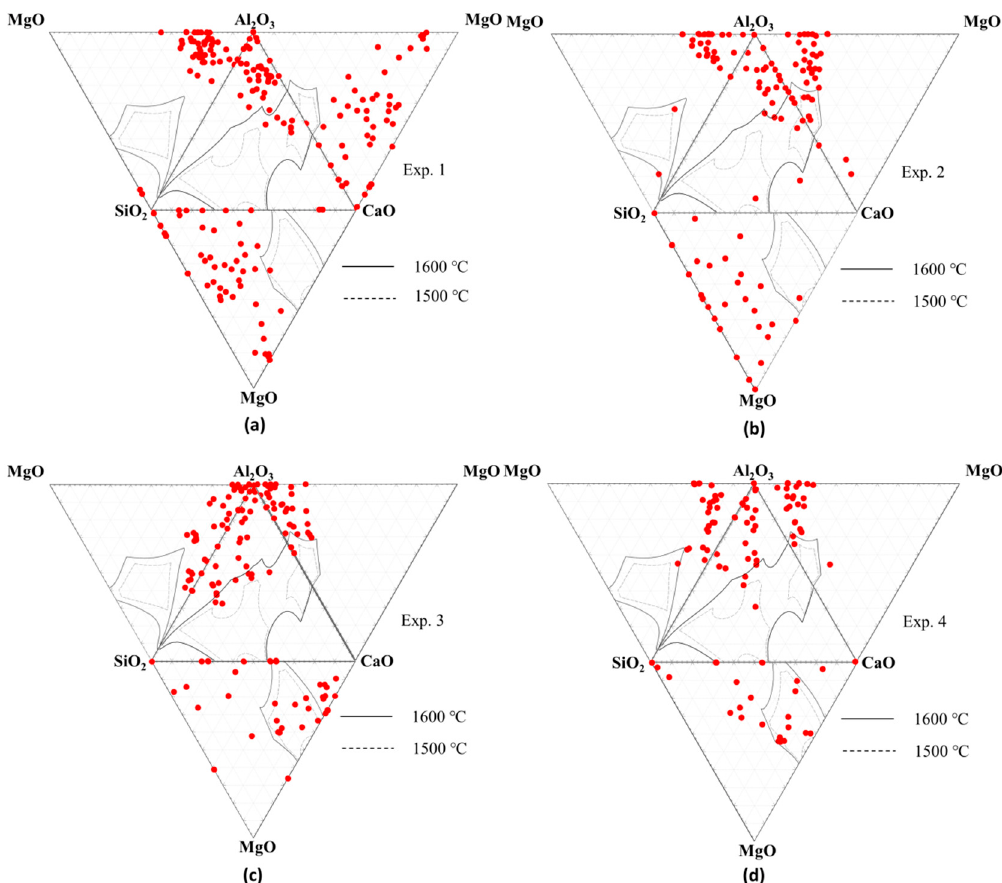
Figure 4. Composition distribution of inclusions in steel billets at different temperatures. ( a ) Experiment 1; ( b ) Experiment 2; ( c ) Experiment 3; ( d ) Experiment 4.